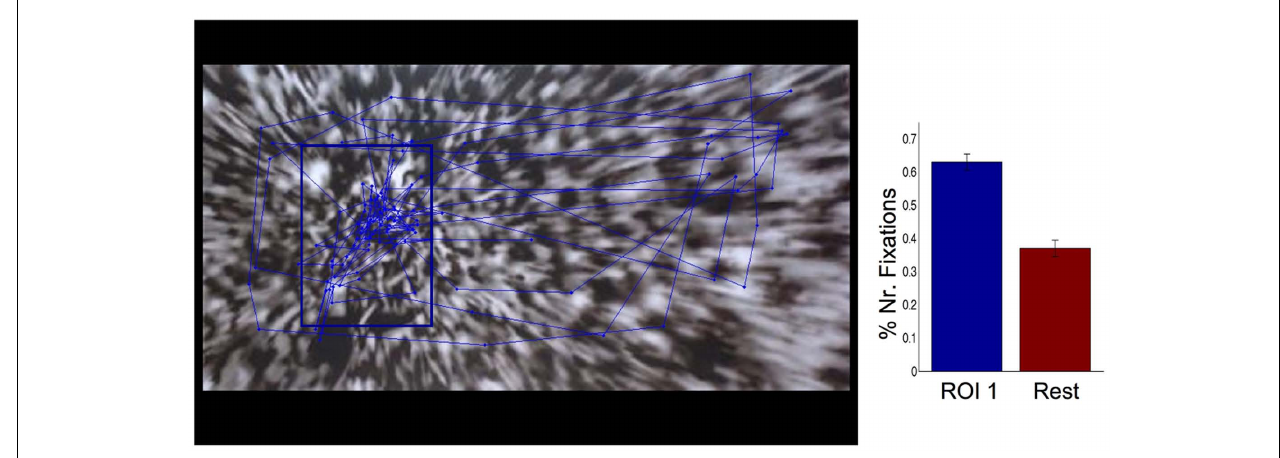
right hand side plot shows the average relative number of fixations for 10 subjects in this region of interest (ROI1, marked in blue in the painting) compared to the rest of the canvas.The lines on top of the bars denote